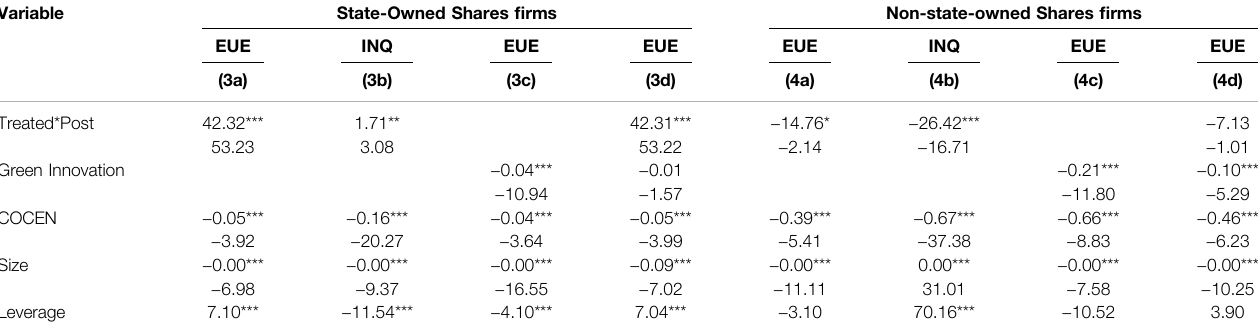
TABLE 9 | Heterogeneity test about